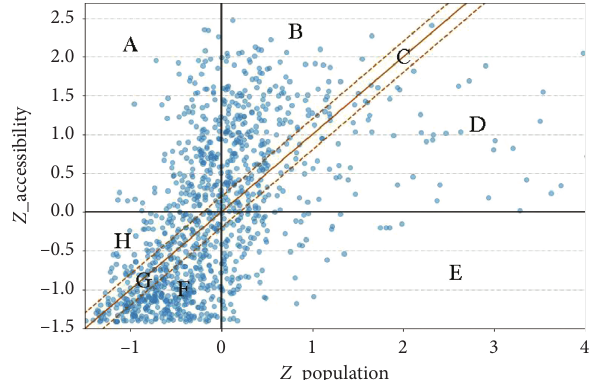
Figure 11: Match the population and accessibility. The yellow line � Z ” and the dotted yellow represents function “ Z accessibility population � Z + 0 . 2” and lines are “ Z accessibility population � Z − 0 . 2” “ Z accessibility population